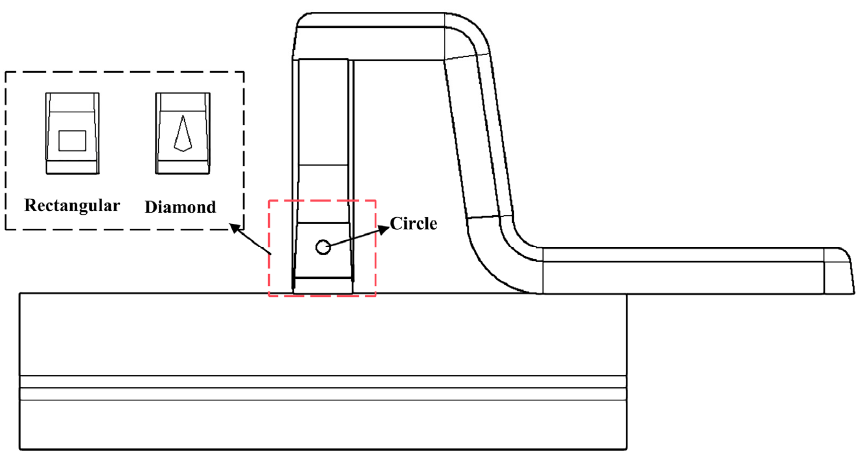
Figure 2. Location and geometrical shape of different inserts.